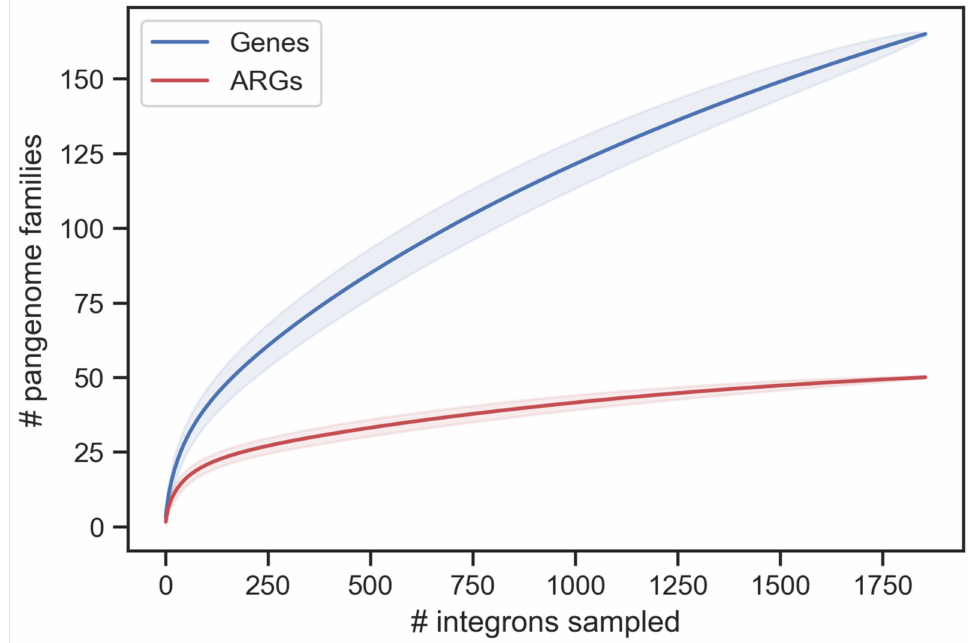
Figure 4. Analysis of the pangenome of the integrons of Kpn . The figure displays two saturation curves, representing the expected (mean) gene richness when increasing the number of integrons. They were computed using the Mao Tau estimate (see Methods for more details). The shadowed regions correspond to one standard